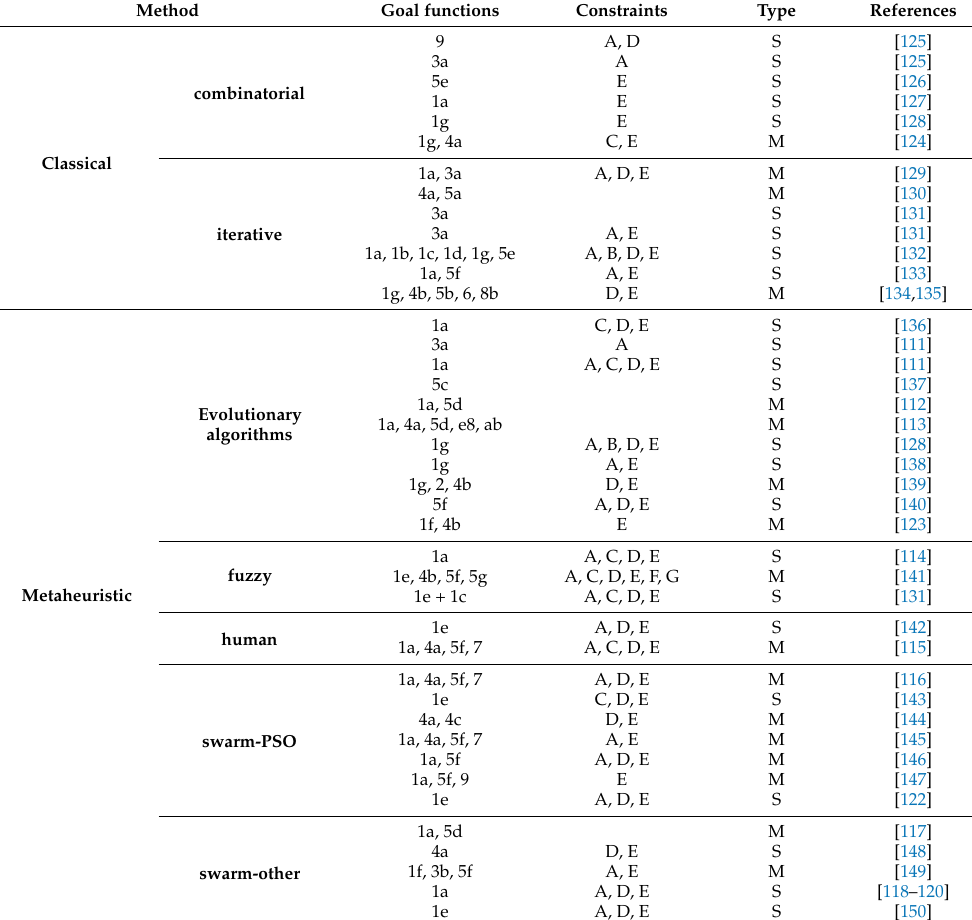
Table 2. Goal functions and constraints (S, single goal function; M, multi-objective).